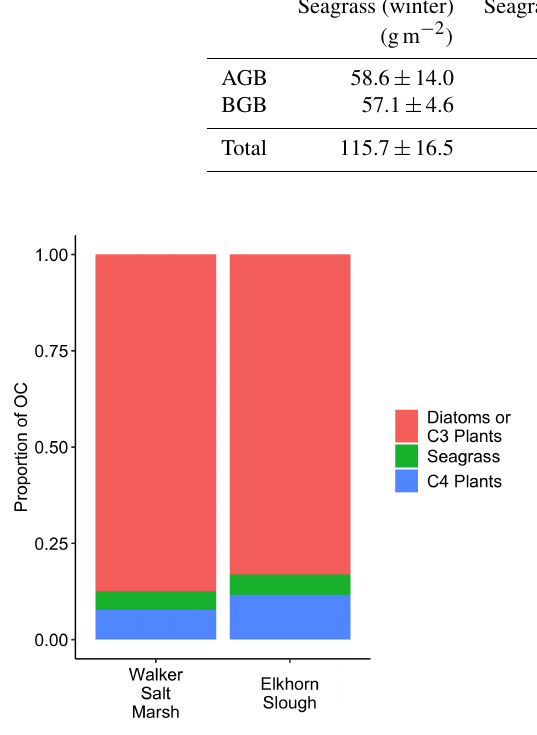
Figure 7. Mixing model results displaying the average source con- tributions to salt marsh sediment organic carbon (OC) for two salt marshes. Exact values and significance are shown in Table